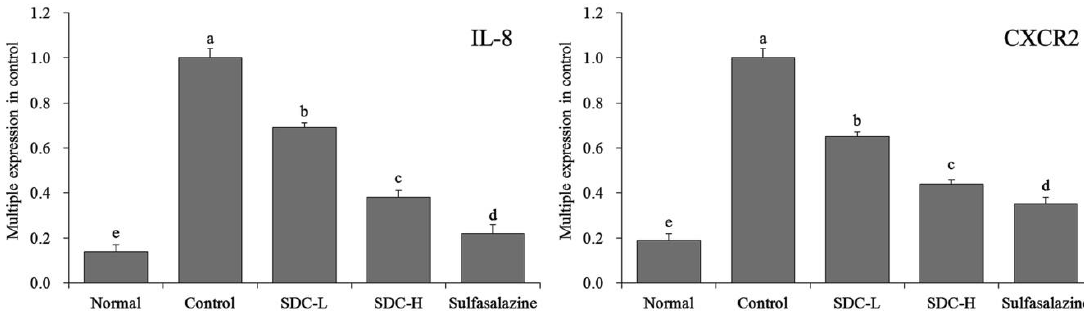
Figure 14. mRNA expression levels of interleukin-8 (IL-8) and C-X-C chemokine receptor type 2 (CXCR2) in the colon tissue of mice. Values represent the mean ± standard deviation. a–e Mean values with different letters in the same bars indicate significant difference ( p < 0.05). SDC-L: 2 g/kg Shuidouchi extract treatment; SDC-H: 4 g/kg Shuidouchi extract treatment; Sulfasalazine: 20 mg/kg sulfasalazine treatment.